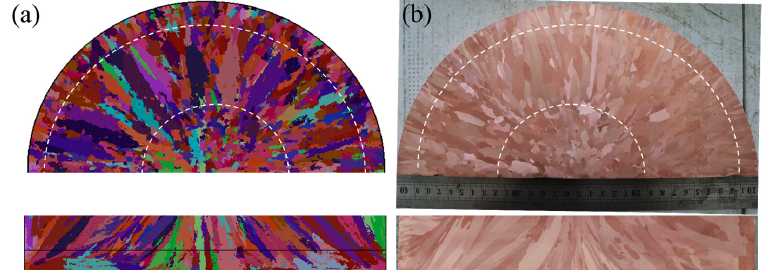
Figure 7. Cross ‐ sectional and longitudinal section solidification structures of the simulated result ( a ) and actual casting billet ( b ).